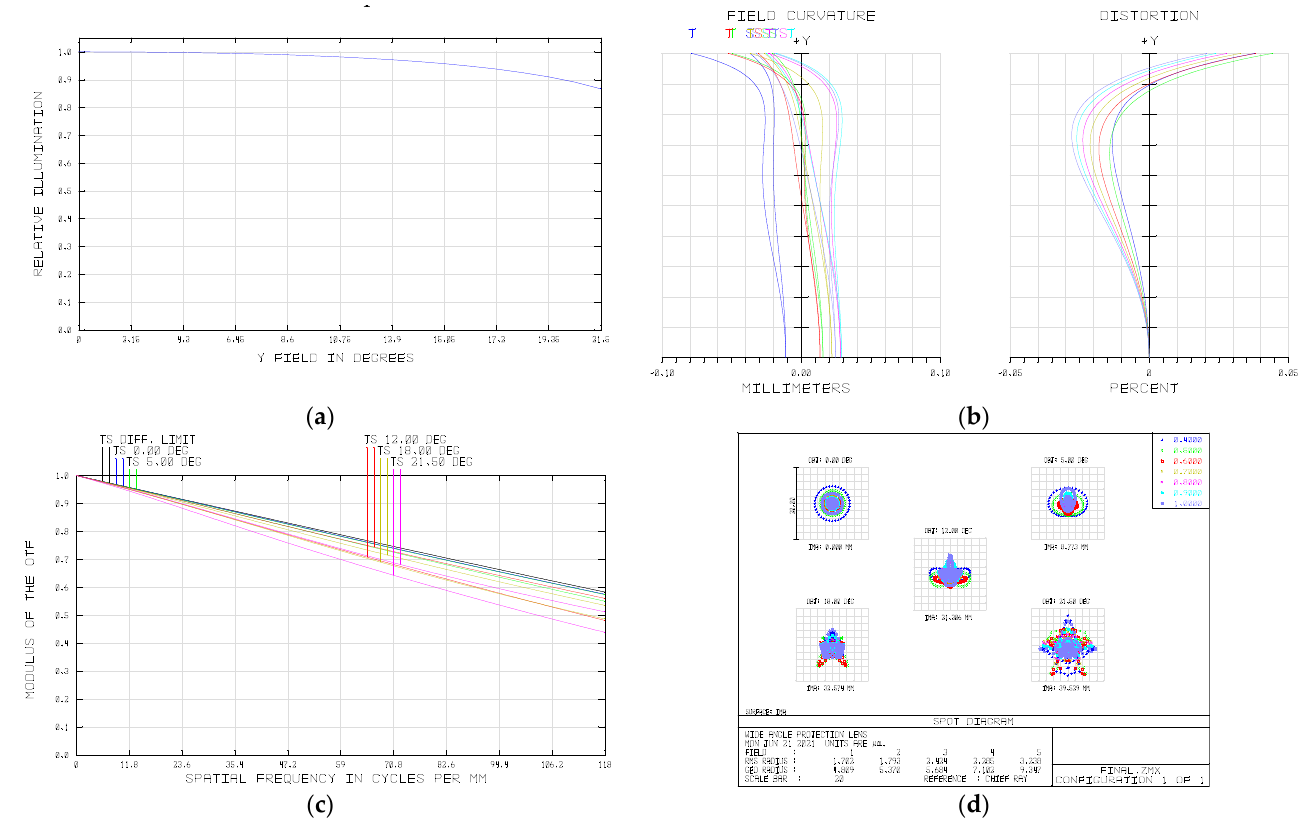
Figure 12. ( a ) Relative illumination of the image plane; ( b ) Field curvature and distortion of the final system; ( c ) MTF of the final system; ( d ) Spot diagram of the final system.